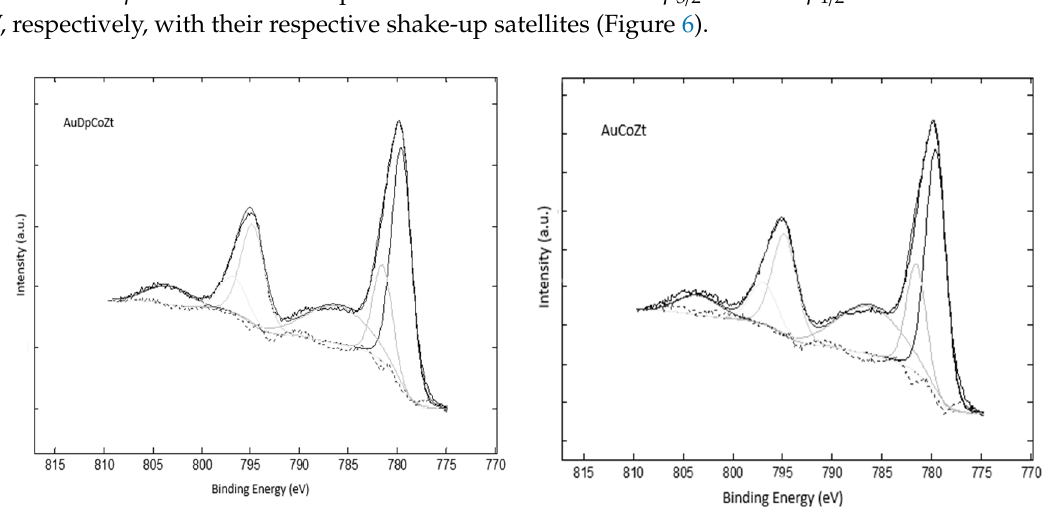
Figure 6. Co 2 p XPS spectra and deconvolution.